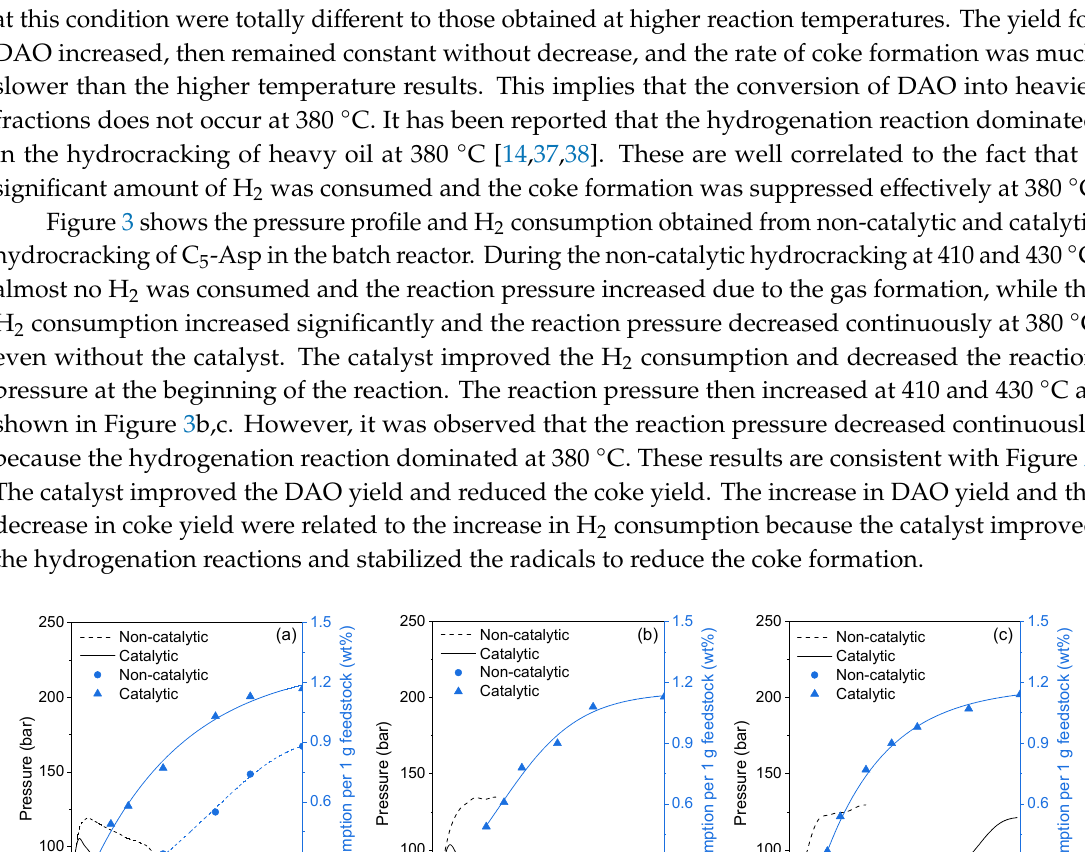
Figure 2. Yields for gas, deasphalted oil (DAO), and coke in catalytic hydrocracking of C5-Asp at ( a ) 380, ( b ) 410, and ( c ) 430 °C and non-catalytic hydrocracking of C 5 -Asp at ( d ) 380, ( e ) 410, and ( f ) 430 °C. Reaction conditions: batch reactor, P H2 = 80 bar at 80 °C, and 1000 wppm of Mo from Mo-octoate in catalytic hydrocracking.